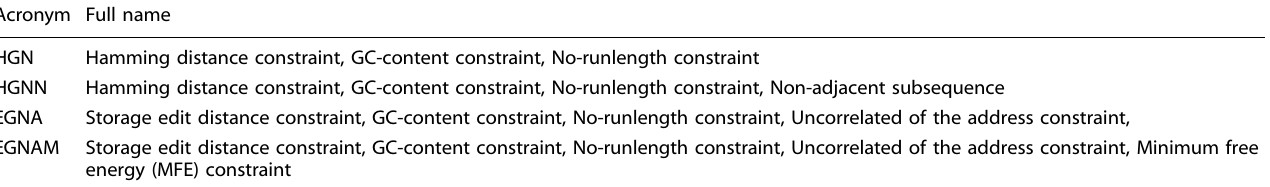
Table 3. Constraint coding condition abbreviation and full name contrast. Acronym Full name